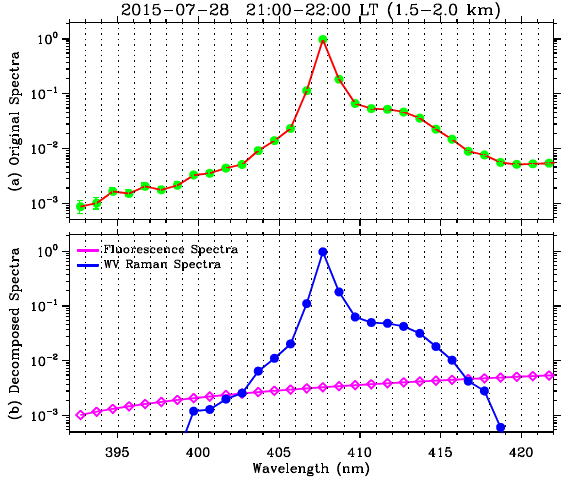
Fig. 2 (a) original normalized spectra by the spectrally-resolved Raman lidar. Error bars indicate statistical uncertainty; (b) separated spectral components after applying the spectra decomposition method: fluorescence spectra (magenta) and lidar-measured water vapor Raman spectra (blue).